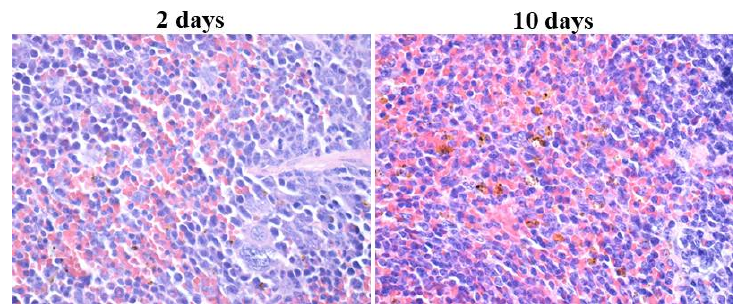
Figure 6. Optical micrographs of splenic tissue harvested after 2 and 10 days of treatment with Fe 3 O 4 @EG (400× magnification).